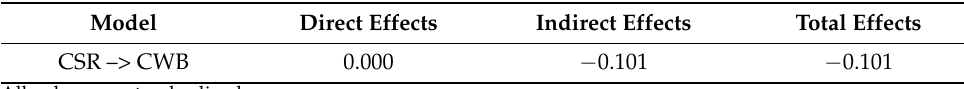
Table 3. Direct, Indirect, and Total Effects of Final Research Model.